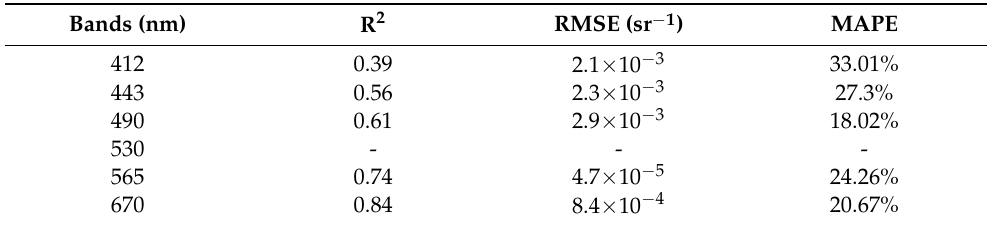
Figure 2. Comparison of in situ measured R rs ( λ ) with SGLI-derived R rs ( λ ) . Table 3. Statistics of R rs ( λ ) measurement for in situ and SGLI data. The parameters include R 2 , RMSE, and MAPE.